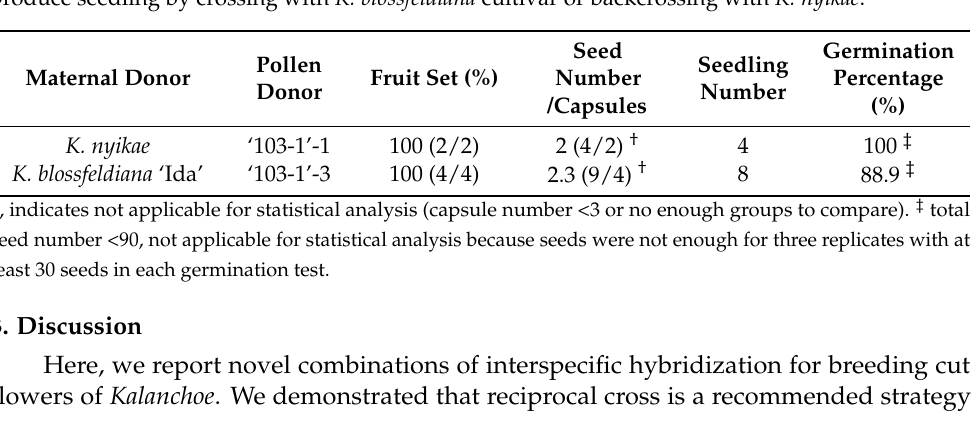
Seed Pollen Fruit Set (%) Donor